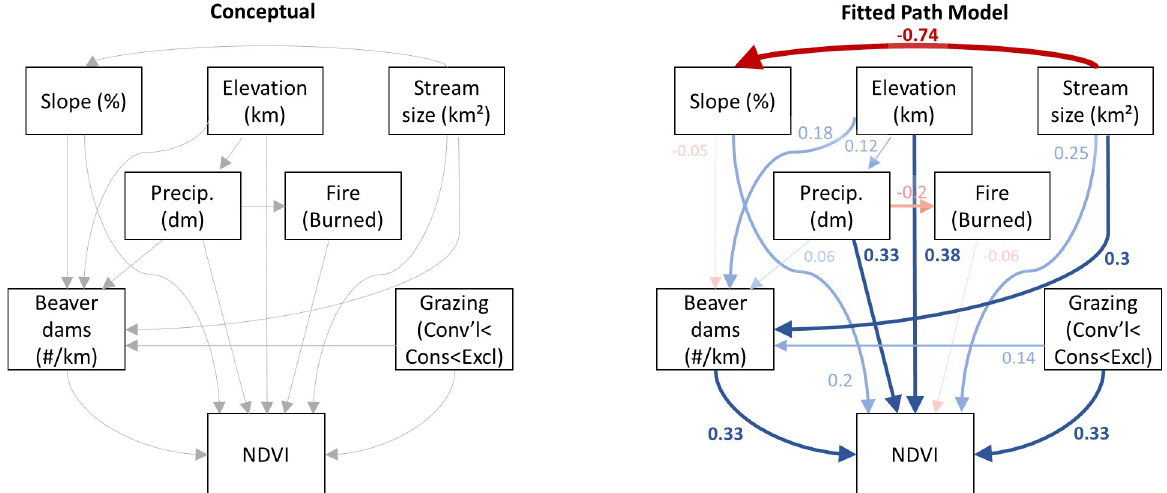
Fig 3. Conceptual and fitted path models. Fitted path model only shows effects with p < 0.05. Blue lines in the fitted model indicate positive effects, and red lines indicate negative effects. Values indicate standardized path coefficients; values around 0.3 are interpreted as moderate effects, while values around 0.1 are interpreted as weak